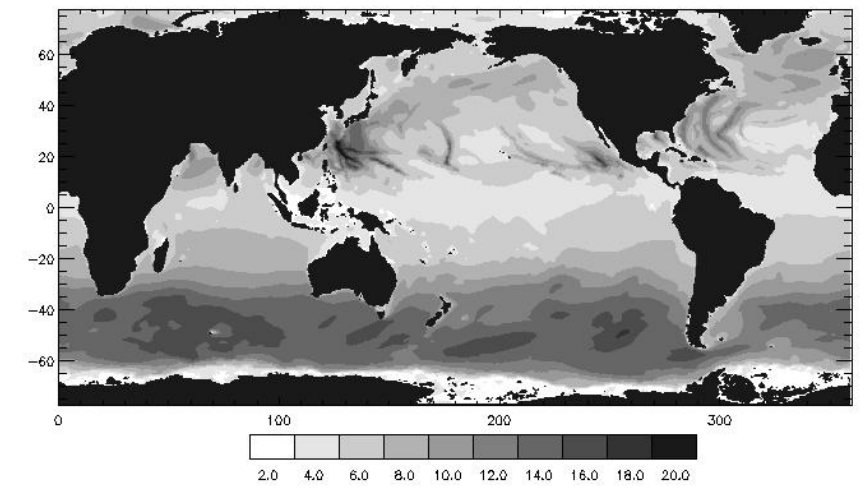
Figure 5. Wave heights above mean level (m) with a cumulative probability of 10 − 7 , for